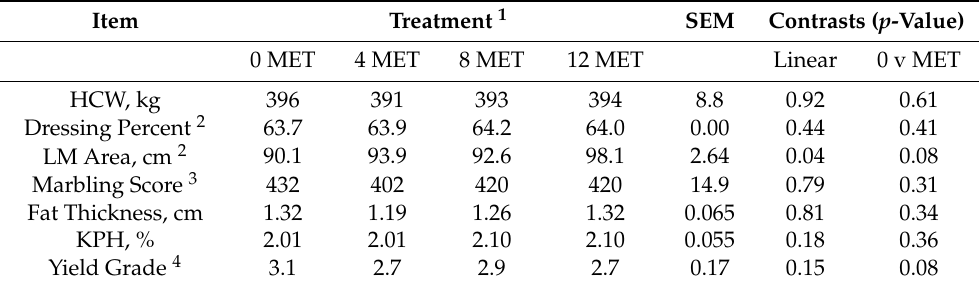
Table 5. Effects of encapsulated methionine (MET) supplementation on carcass